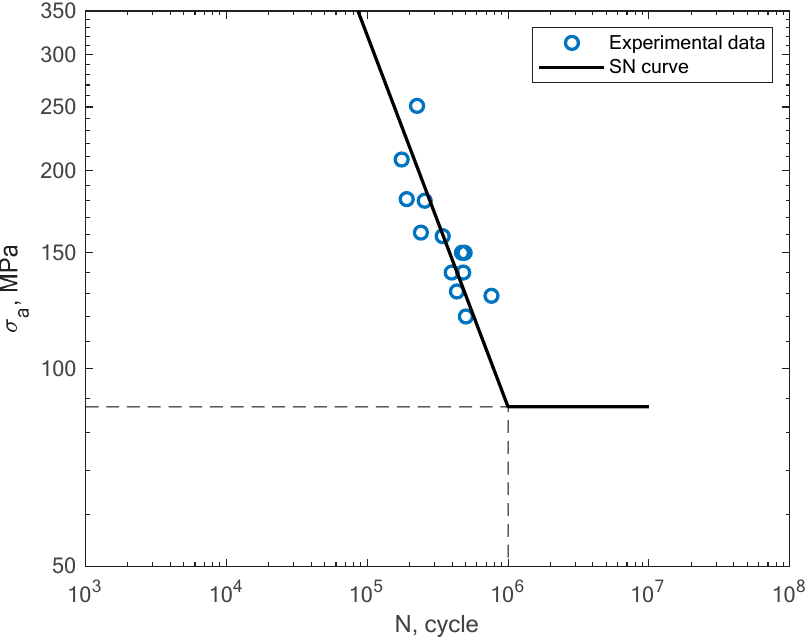
Figure 11. S–N curve for the experimental bending fatigue test results reported by Kostic et al. [2] for the case of no heat treatment and no machining.